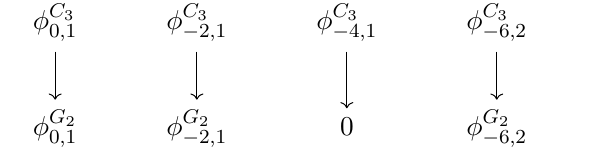
Figure 2 . The specialization of J ( C 3 ) to J ( G 2 ) generators. The vertical lines correspond to setting x 1 + x 2 + x 3 = 0 and multiplying by a